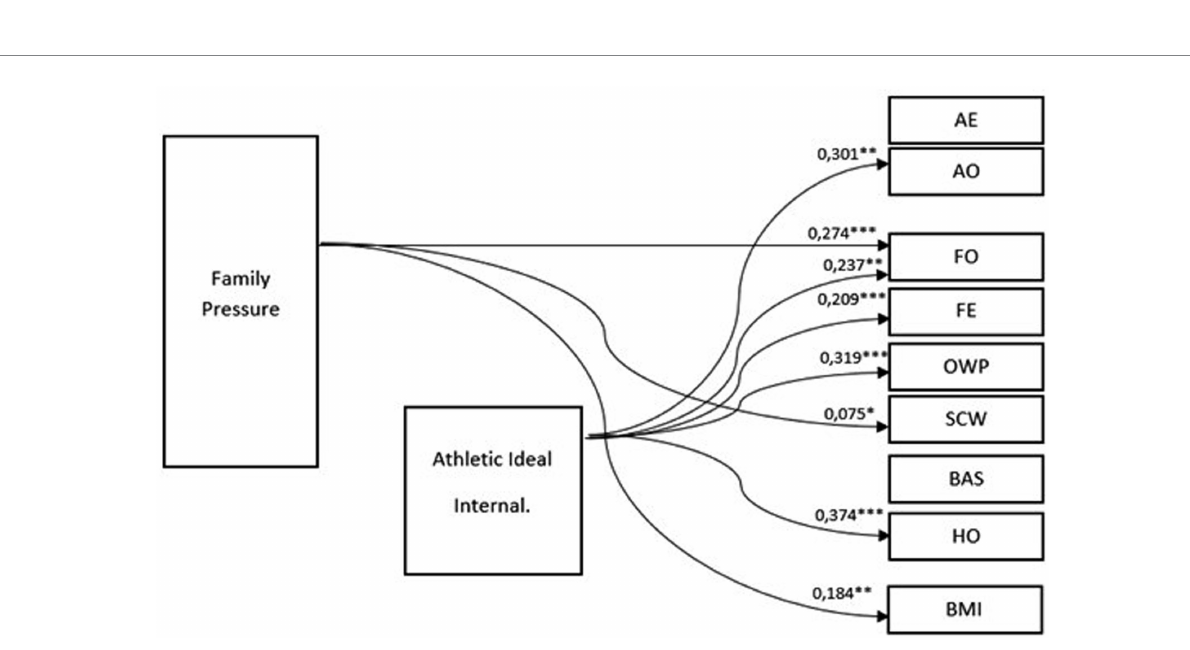
Figure 4, internalization affects five components of body image: (1) health orientation (HO, 0.374), which means an increase in investment in physical body health and a healthy lifestyle as internalization increases; (2) overweight preoccupation (PLO, 0.319), indicating that greater internalization is accompanied by a greater fear of weight gain;